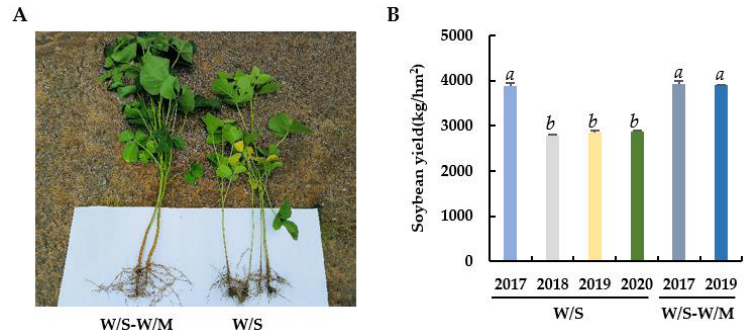
Figure 1. Comparison of soybean plant morphology ( A ) and yield in each year ( B ) between two cropping systems. W/S-W/M, wheat/soybean-wheat/maize rotation system; W/S, continuous wheat/soybean cropping system. Different letters above columns signified statistically significant difference ( p <